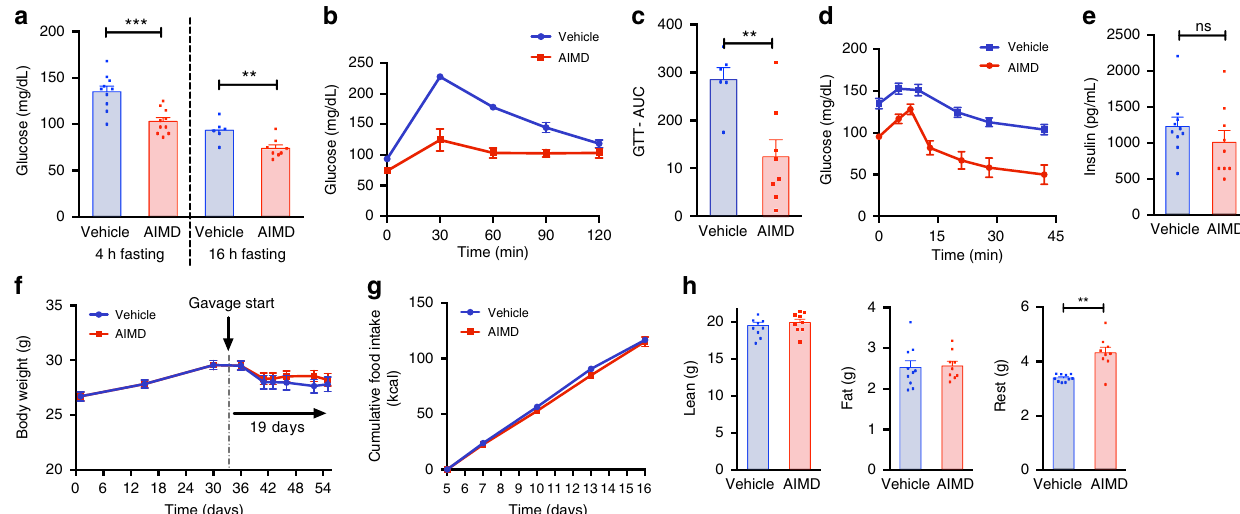
Fig. 2 AIMD improves glucose tolerance and insulin sensitivity. a Blood glucose levels after 4 or 16 h of fasting. b , c Blood glucose concentration after IP injection of a glucose bolus (1 g/kg BW) (GTT) ( b ) and area under the curve quanti fi cation ( c ). d Blood glucose levels after IP injection of insulin (0.75 U/ kg BW) (ITT). e Fasting serum insulin levels. f Body weight before and after the start of antibiotics gavage. g Cumulative food consumption (kcal) after acclimation to gavage. h Body composition as a percentage of total body weight. f – h were replicated in a separate experiment (Supplementary Figure 2). GTT and glucose measures were performed 3 weeks after intervention, and ITT was performed 4 weeks after intervention. Unpaired Student ’ s t test, ** p < 0.01, *** p < 0.001, ns nonsigni fi cant. All error bars are